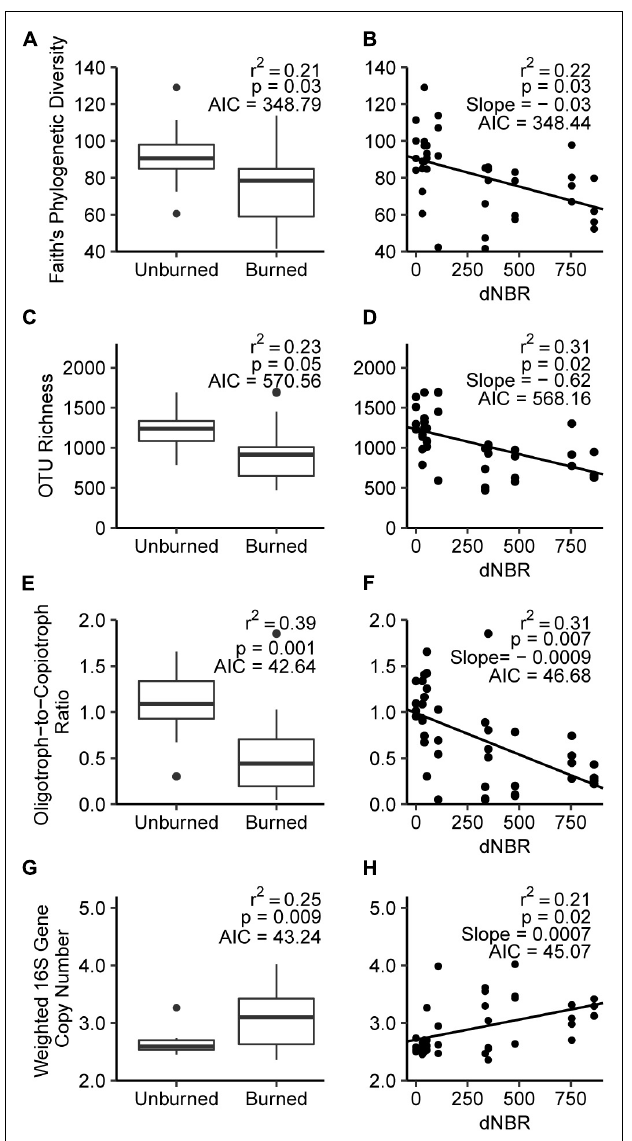
FIGURE 2 | Relationship between fire occurrence and severity for selected microbial community characteristics, including Faith’s phylogenetic diversity (A,B) , OTU richness (C,D) , oligotrophic-to-copiotrophic taxa ratio (E,F) , and weight 16S gene copy number (G,H) .